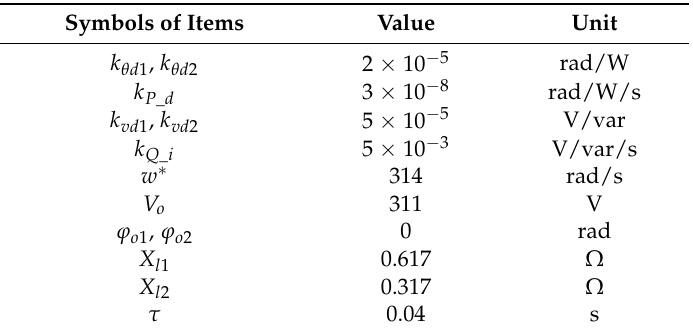
Table 1. Parameters of the parallel system.